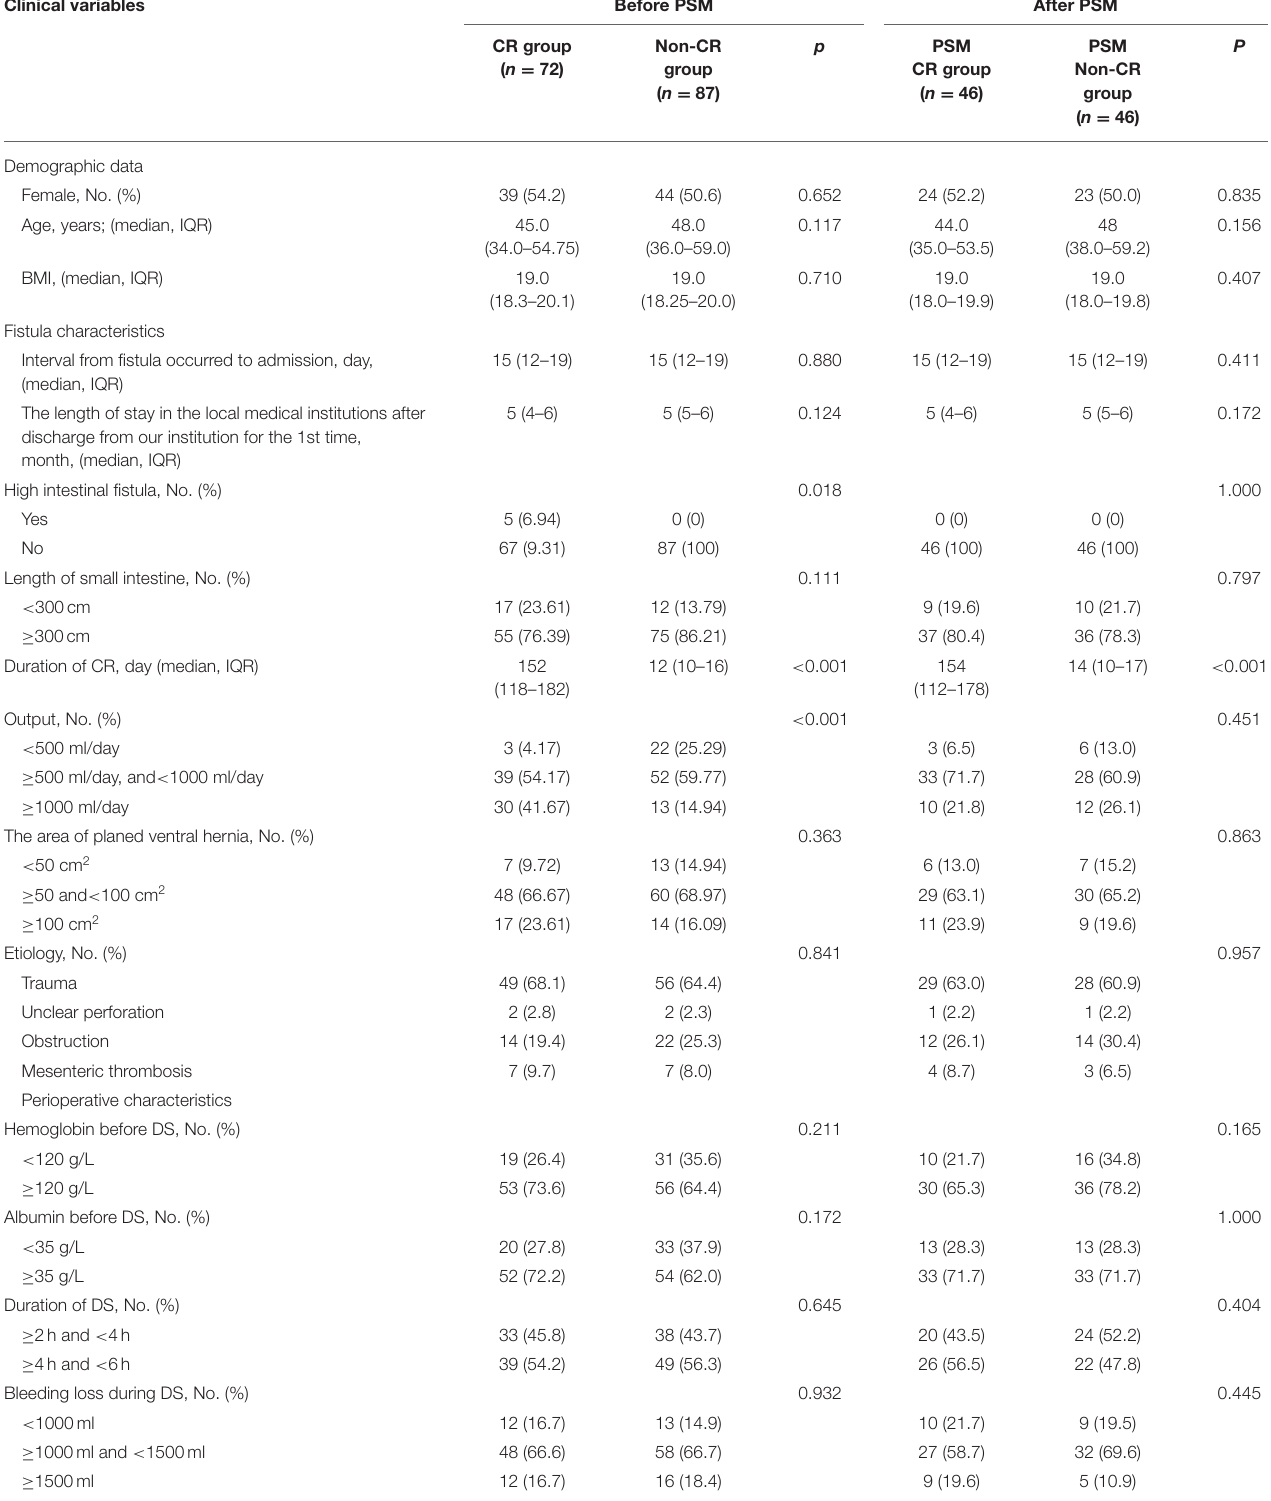
TABLE 2 | Patients